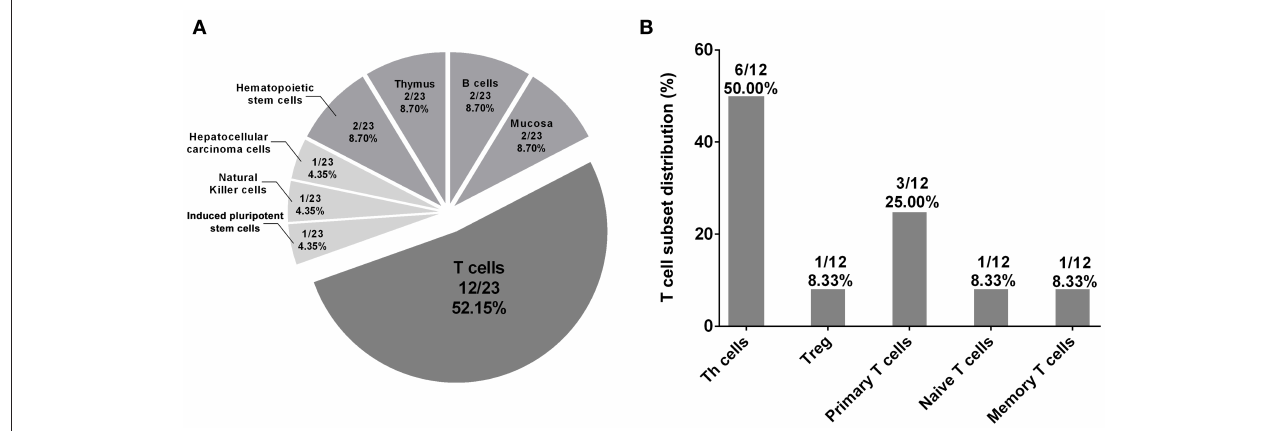
FIGURE 4 | Tissue enrichment analysis of regulatory effects of rs3093023 and its proxies. (A) The significantly enriched tissues/cells ( p < 0.05) of the regulatory effects of rs3093023 and its proxies. (B) The distribution of T cell subset enriched for regulatory effects of rs3093023 and its proxies. SNPs, single-nucleotide polymorphisms.